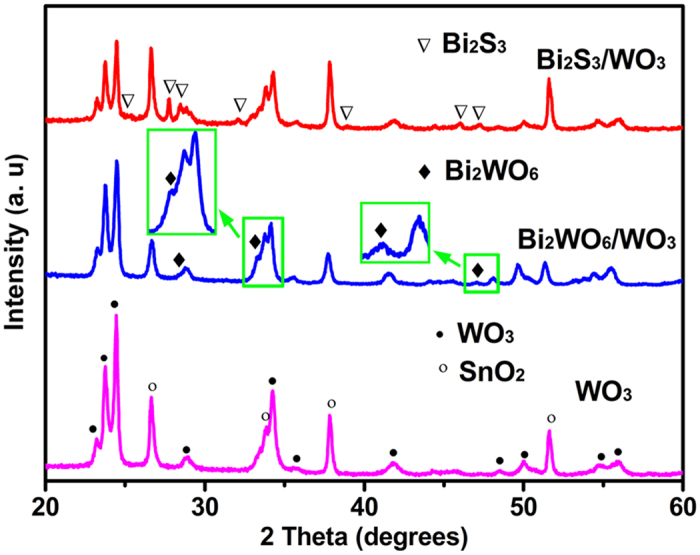
XRD patterns the WO3, Bi2WO6/WO3 and Bi2S3/WO3 film.